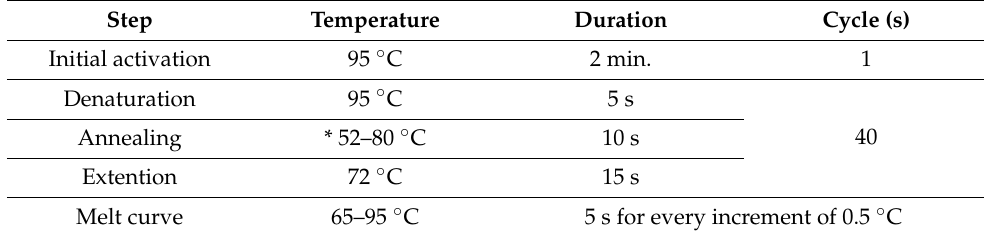
Table 4. Cycling parameters for RT q-PCR.